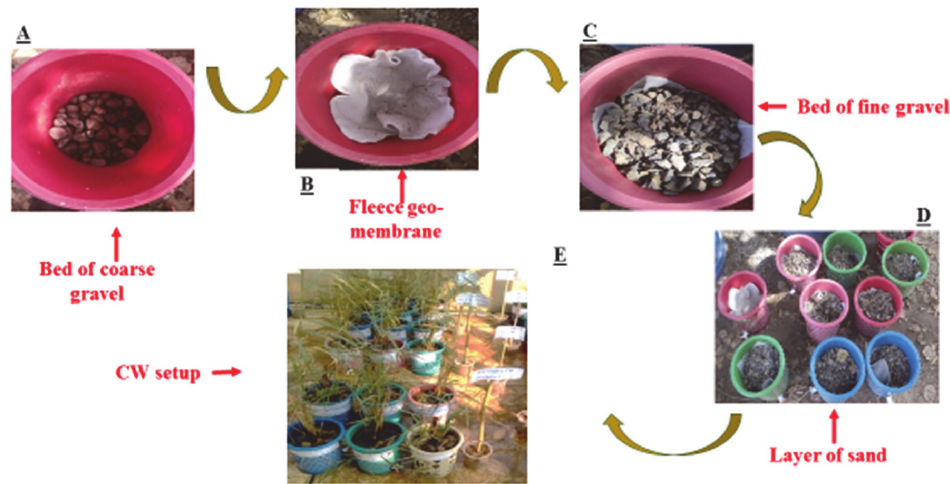
Figure 3. Development of constructed wetlands. Where, ( A ) shows the bed of coarse gravel, ( B ) shows fleece membrane, ( C ) shows bed of fine grave, ( D ) shows layer of sand, and ( E ) shows experimental setup.